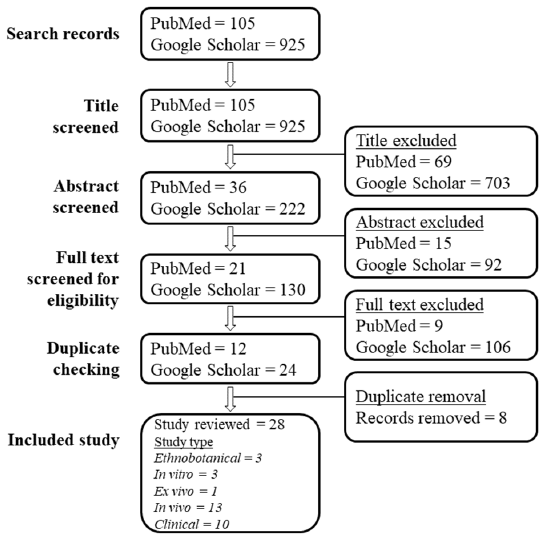
Figure 1. Preferred reporting items for systematic review and meta-analysis (PRISMA) chart of ar- ticles searching and screening. Note: One included study conducted in vitro, ex vivo and in